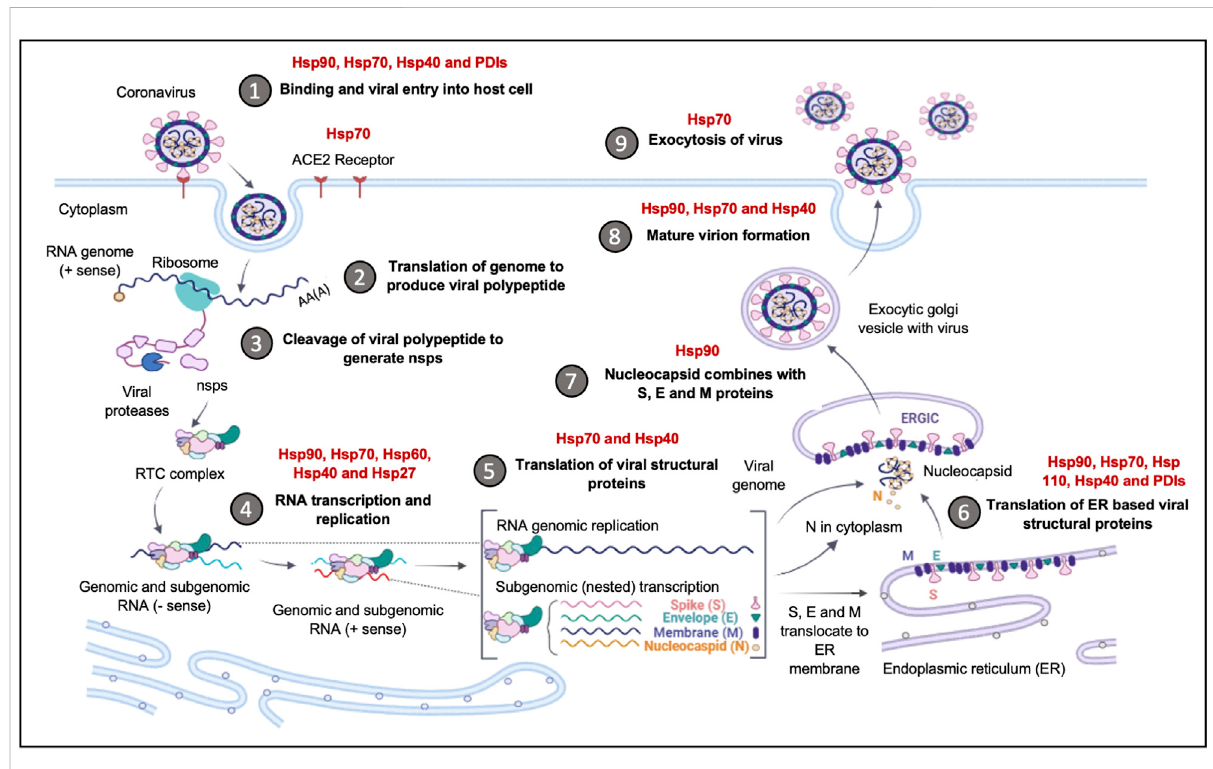
FIGURE 5 The upregulation of Hsps facilitates Coronavirus invasion and replication. The Hsps implicated in the Coronavirus replication cycle are highlighted.ThebindingandentryoftheviralparticleisachievedthroughtheACE-2receptor,withHsp90,Hsp70,Hsp40andPDI,actingasauxiliary receptors. Upon viral entry and initial translation and transcription, Hsp40, Hsp70, Hsp60 and Hsp27, are recruited to facilitate in viral protein maturation. The folding of structural proteins is assisted by Hsp70 and Hsp90. The ER-resident chaperones, Grp94, Grp78, ERDnaJ and PDIs, facilitate the folding and insertion of viral proteins onto the ERGIC membrane. The formation of the nucleocapsid complex is overseen by Hsp90, while viral exocytosis requires the cooperation of Hsp90, Hsp70 and Hsp40. Image created with